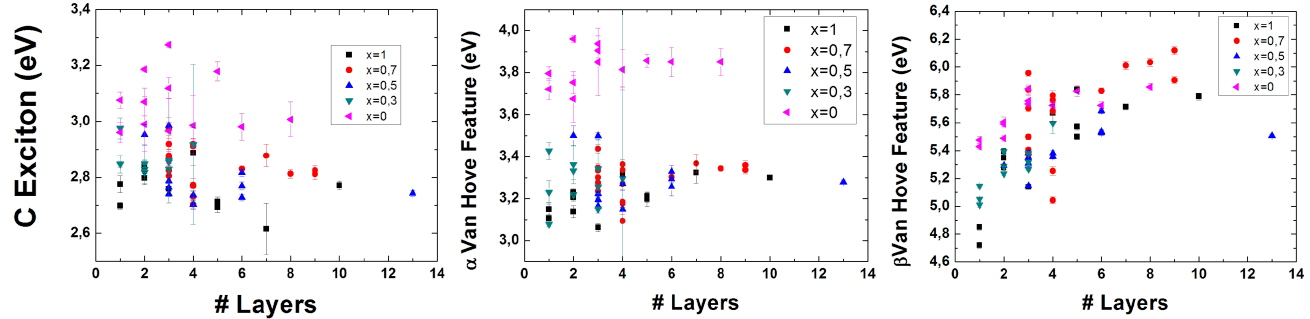
Figure A5. Raw results of the analyses in these works. Left to right: C exciton, α and β van Hove